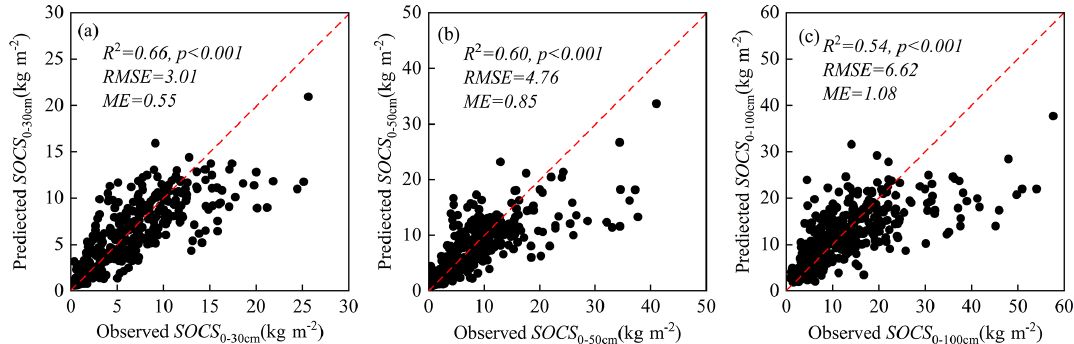
Figure 6. “Leave-one-out” cross-validation for the RF model used to predict the SOCS at (a) 0–30cm, (b) 0–50cm, and (c) 0–100cm depth